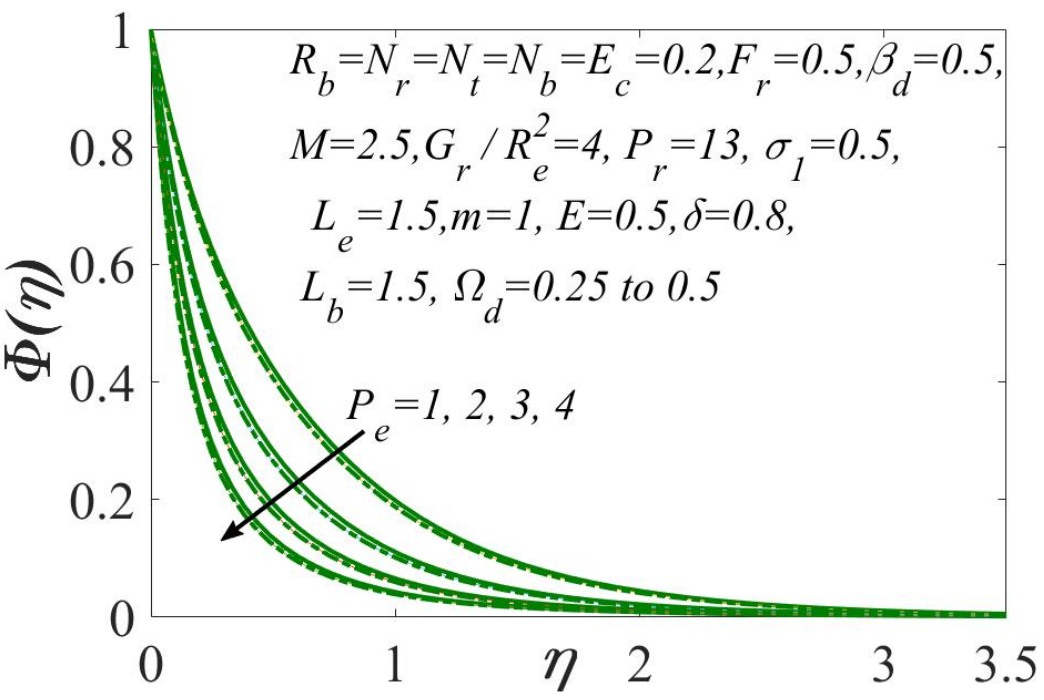
Figure 15. E ff ect of the Peclet number P e and the microorganisms concentration variance parametric Figure 15. Effect of the Peclet number (cid:1842) (cid:3032) and the microorganisms concentration variance parametric quantity Ω d on the density of motile microorganisms. Solid line: Ω d = 0.25, Dotted line: Ω d = quantity (cid:2007) (cid:3031) on the density of motile microorganisms. Solid line: (cid:2007) (cid:3031) = 0.25 , Dotted line: (cid:2007) (cid:3031) = 0.5 .